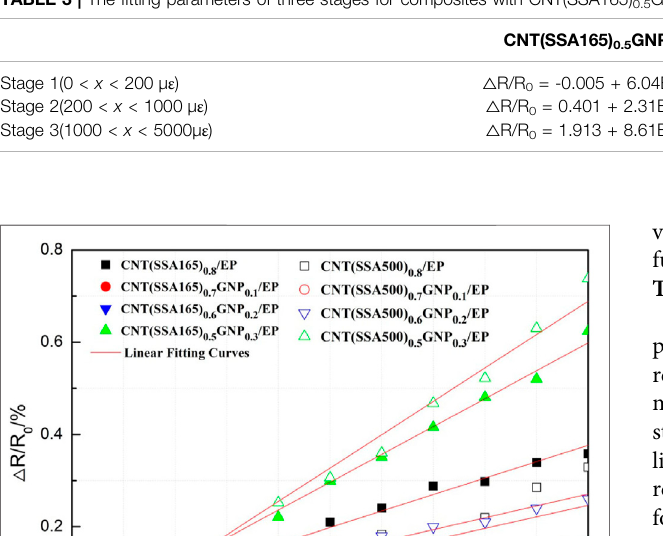
Frontiers in Materials |